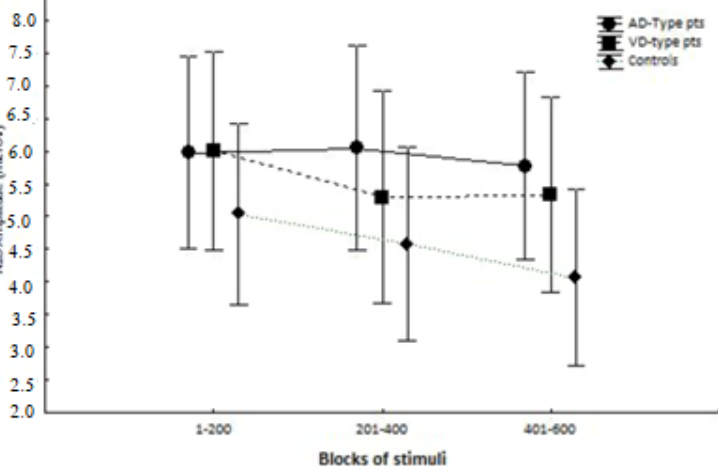
Figure 2. Lack of SEPs habituation from block 1 to block 3 in a representative patient with AD-type cognitive disorder. Top row grand average of trials 1-200 (block 1), mid row grand average of trials 201-400 (block 2), bottom row grand average of trials 401-600 (block 3).